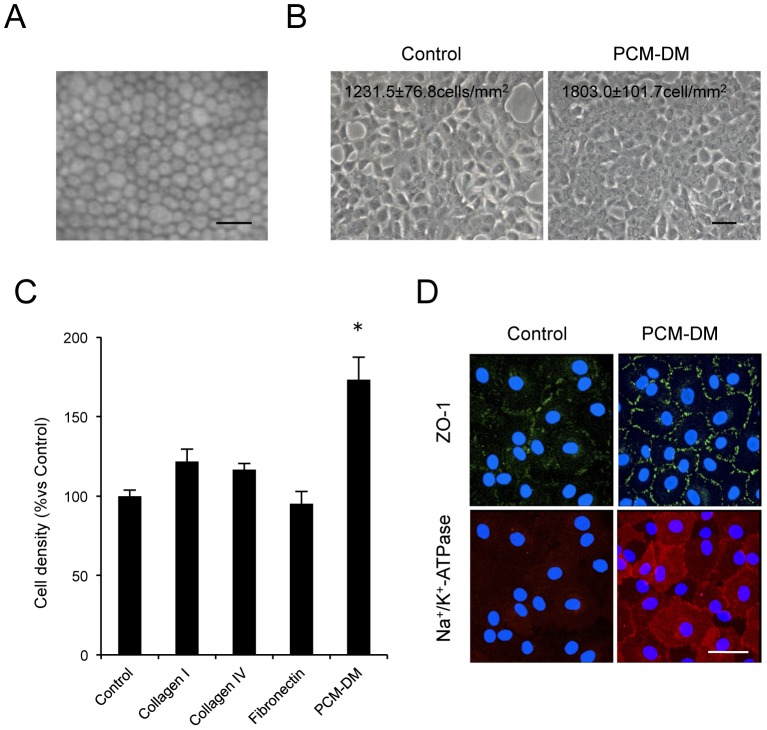
Characteristics of cultivated HCECs on PCM-DM.(A) An image of corneal endothelium of a normal human subject was obtained by in vivo contact specular microscopy. Scale bar: 100 µm. (B) The HCECs (passage 3) were passaged on the PCM-DM and on the control culture dish and cultured for 30 days to form a monolayer sheet. Representative phase contrast images are shown. Scale bar 100 µm. The experiments were performed in triplicate. (C) The HCECs were passaged on the noncoated plate (control), collagen 1, collagen 4, fibronectin, and PCM-DM and cultured for 30 days. The cell densities of the HCECs were evaluated by KSS-400EB software. The experiments were performed in triplicate. (D) ZO-1 and Na+/K+-ATPase at the plasma membrane was stained in the HCEC culture on the PCM-DM and on the control culture plate. Scale bar 50 µm.